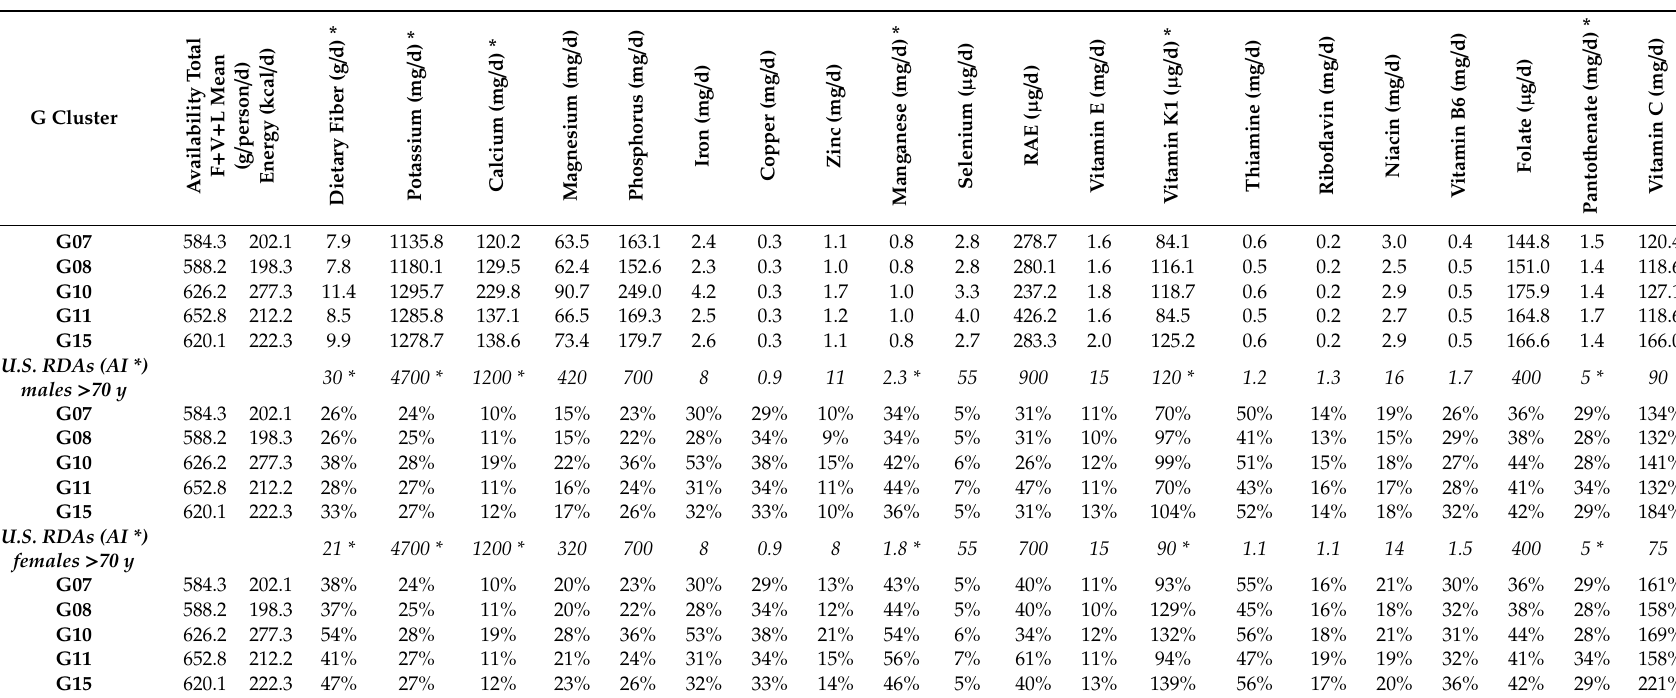
Table 3. IEDI cluster diet database estimating the daily availability of fiber and nutrients from total fruits, vegetables, and legumes. Estimated data were determined and summed from the mean availability of each individual product in the IEDI cluster diet database and corresponding nutrient data in food conversion databases for geographical cluster zones corresponding to countries with consumption data used in this study. Percentage contributions of estimated daily availability of fiber and nutrients from fruits, vegetables, and legumes towards the US recommended dietary allowances (RDAs) or adequate intakes (AIs *) are shown for males and females aged > 70